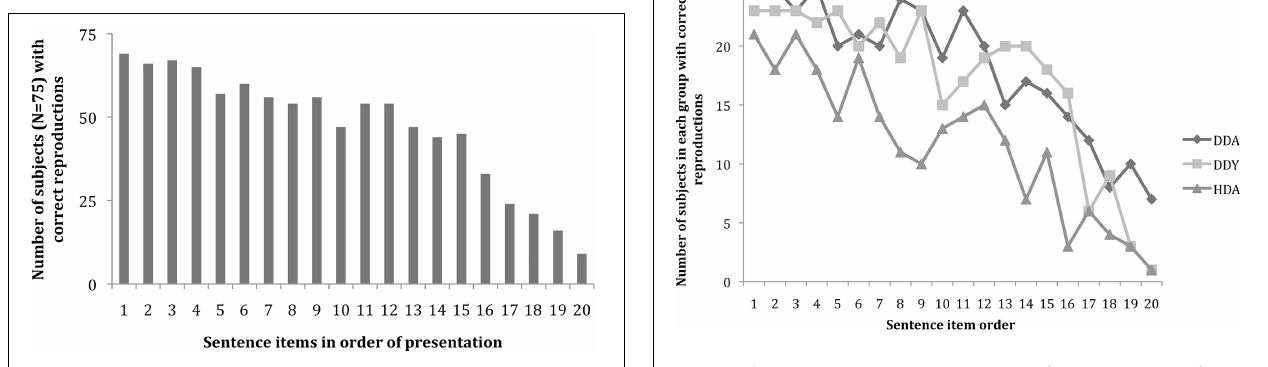
FIGURE 1 | Histogram of participants with correct reproduction for each of the 20 sentences in the ASL-SRT task ( N = 75 subjects).